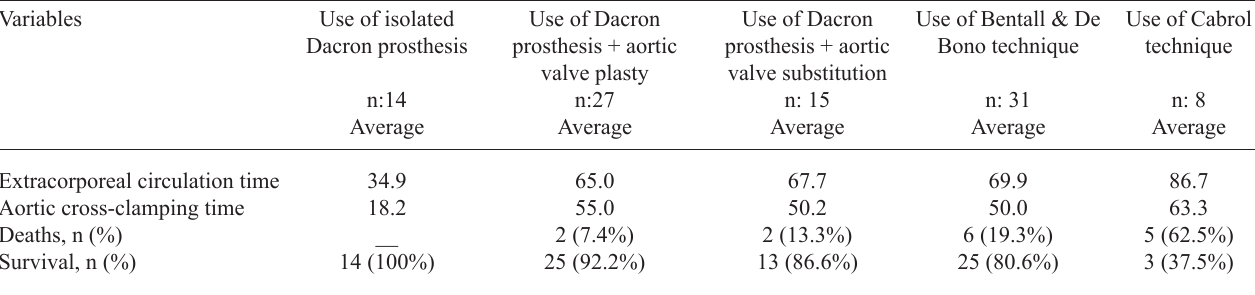
Table 3. Types of surgical techniques of the 95 patients related to ECC and aortic cross-clamping times and mortality. Variables